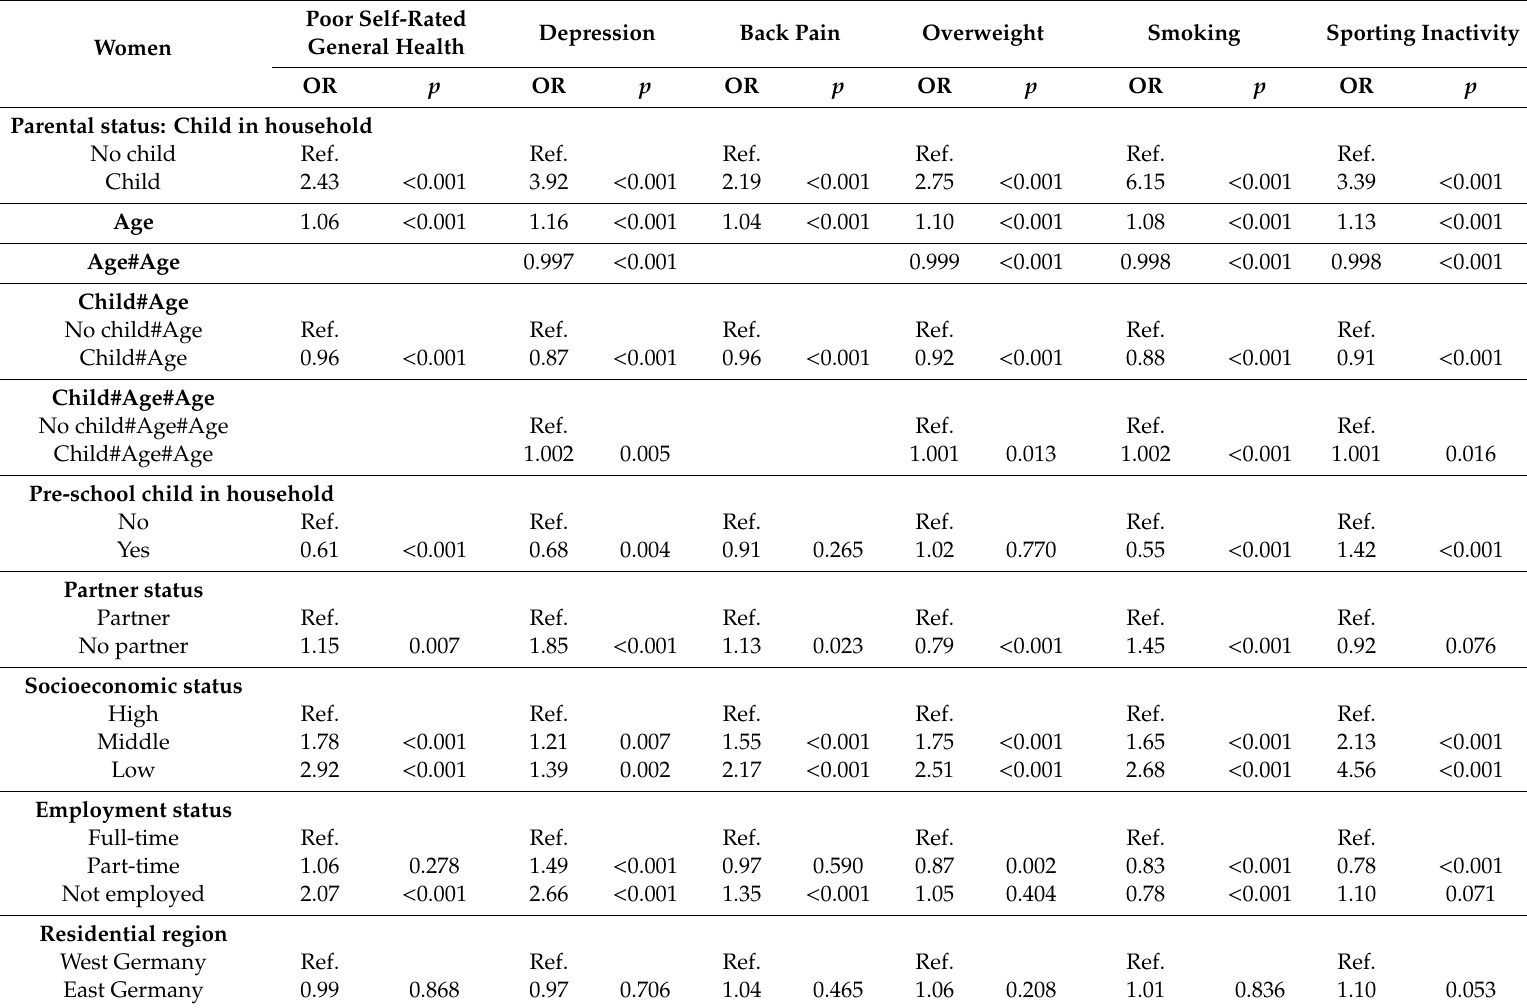
Table 3. Results of the logistic regressions with interaction of parental status and age for women (odds ratios, p values; age (metric) centered at the minimum of 18